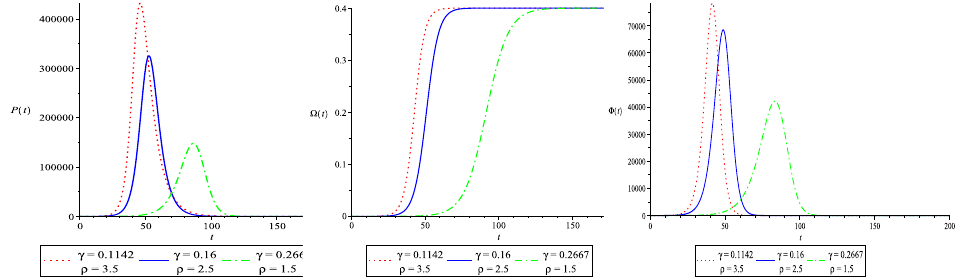
Figure 2. The effect of quarantine and other preventative measures on EP, FOI and ROI for N = 10 6 and 0 ≤ t ≤ 200. The value of β = 0.4 is fixed and, to lower ρ , the value of γ is increased. We used S ( 0 ) = 10 6 − 5, A ( 0 ) = 2, I ( 0 ) = 3 and Q ( 0 ) = 0. The parameters are measured in (day − 1 ) . The time t is taken on the horizontal axis and is measured in